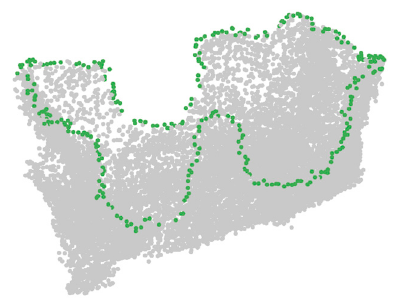
Figure 5. Example of hole boundary point detection result: the green points are the hole boundary points.